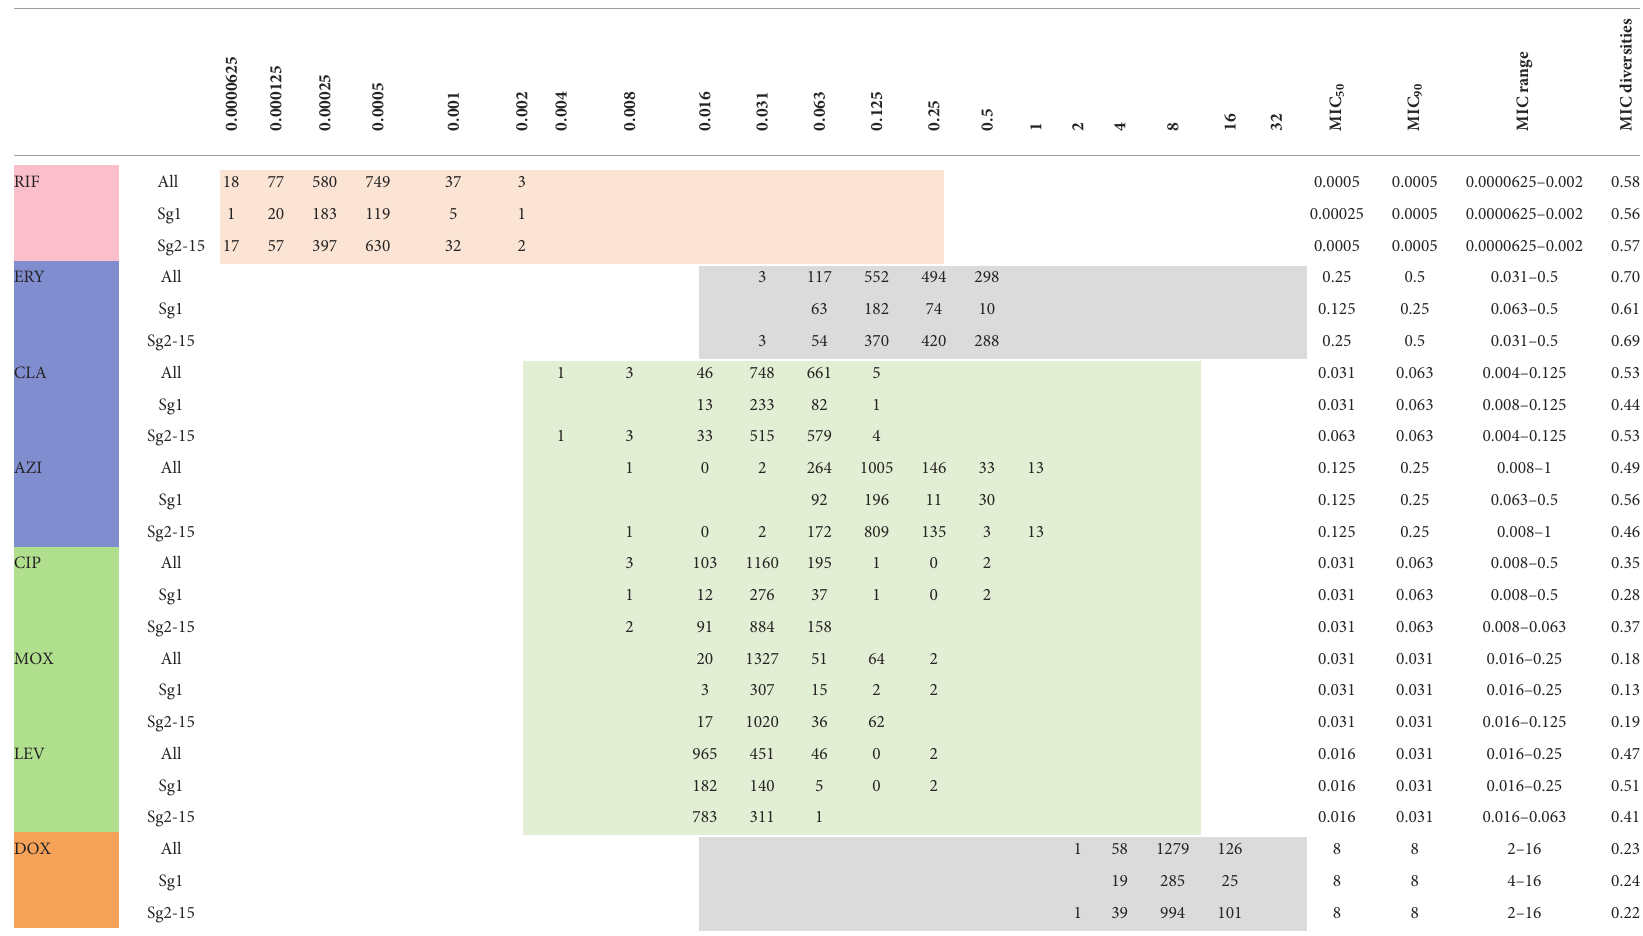
TABLE 1 Minimum inhibitory concentration (MIC) data of eight antimicrobials for the 1464 L. pneumophila isolates.